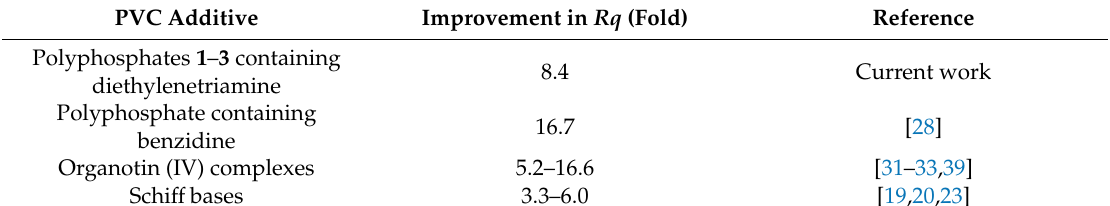
Table 4. Improvement roughness factor ( Rq , fold) of PVC films containing various additives.